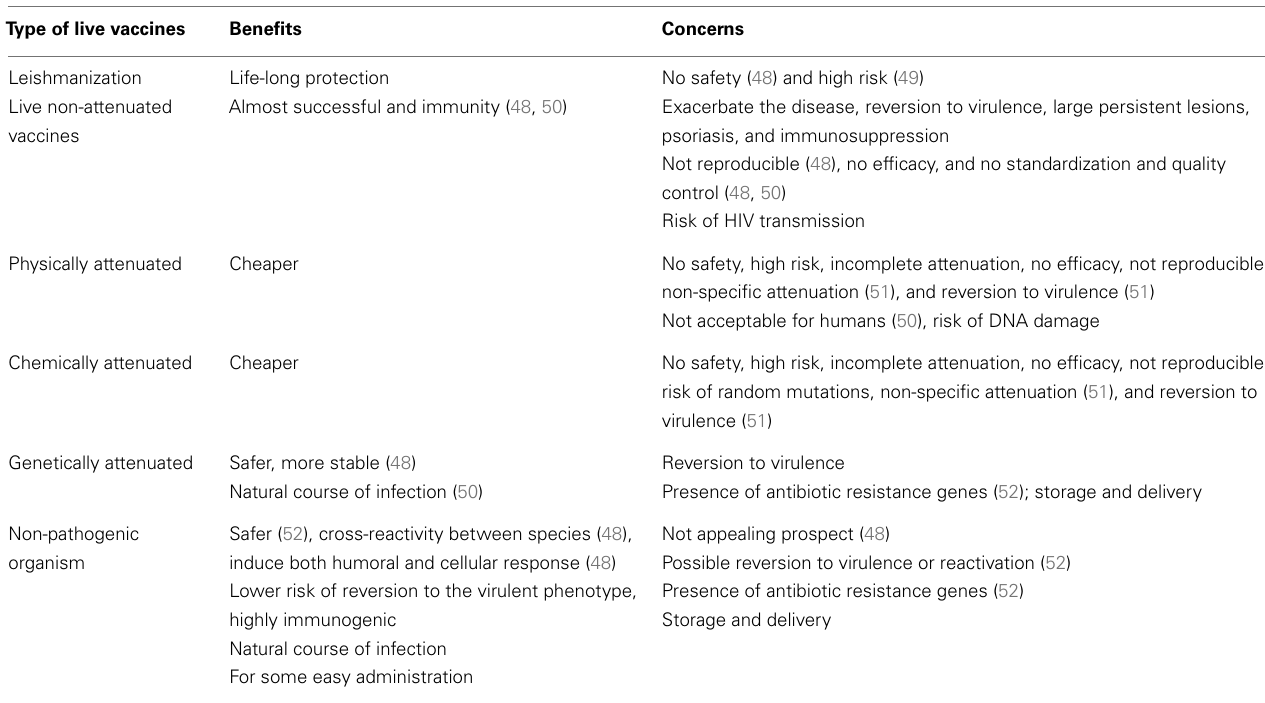
Table 2 | Properties of different types of live vaccines based on whole